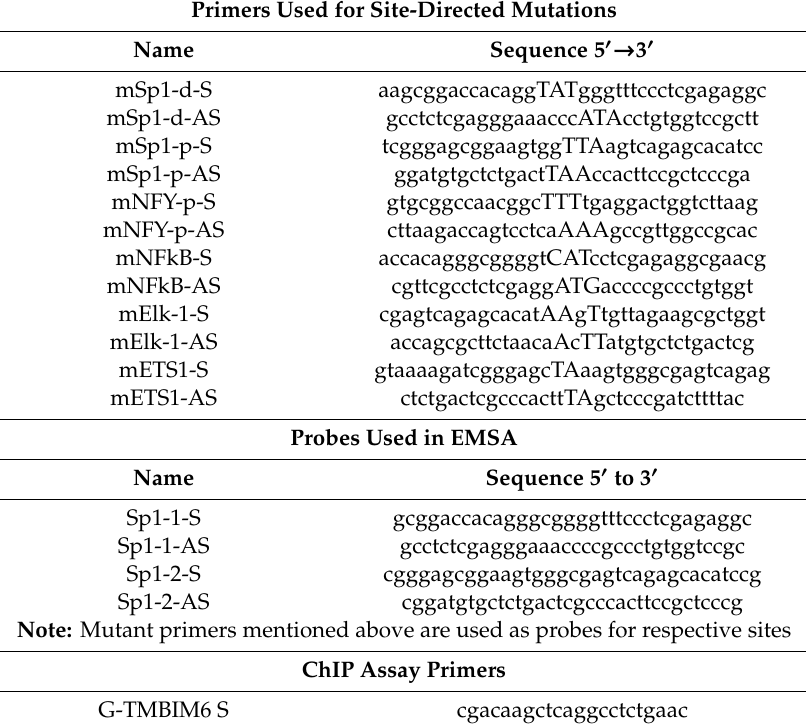
Table 2. Primers / probes used for site-directed mutations and the EMSA and ChIP assays. Primers Used for Site-Directed